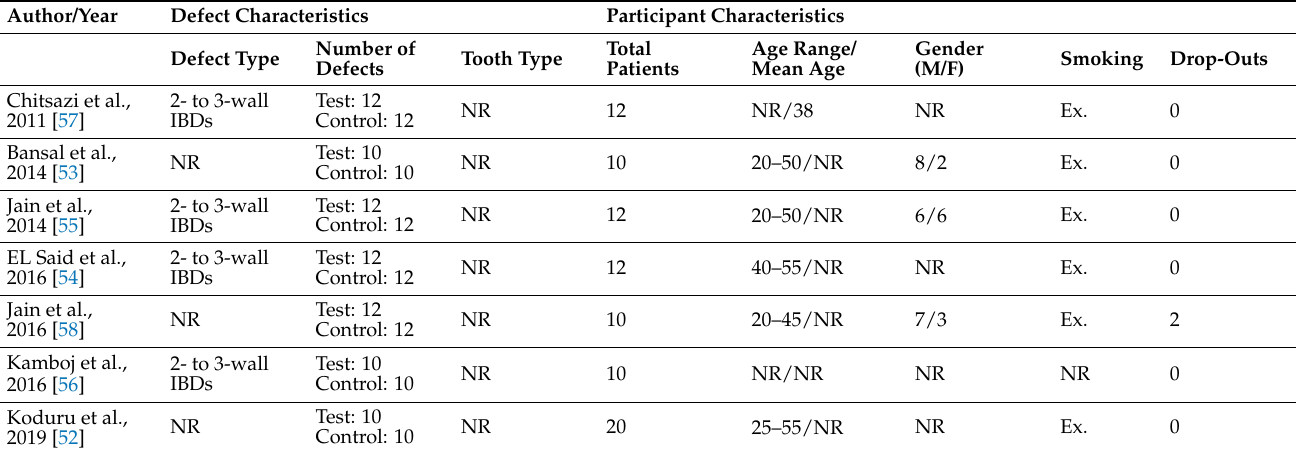
Table 3. Defect and participant